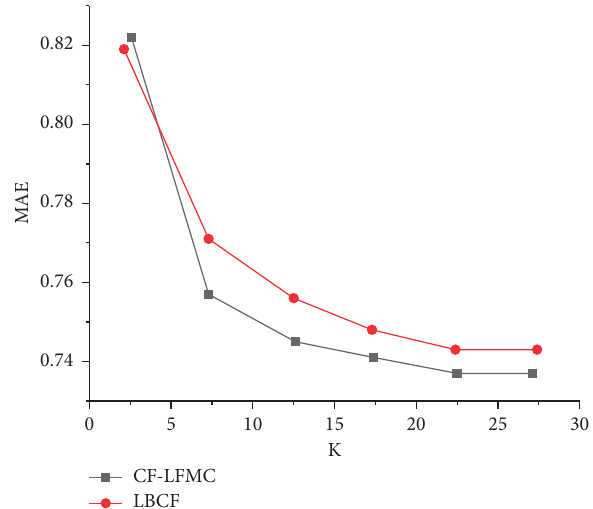
Figure 2: MAE of CF-LFMC and IBCF varies with the number of nearest